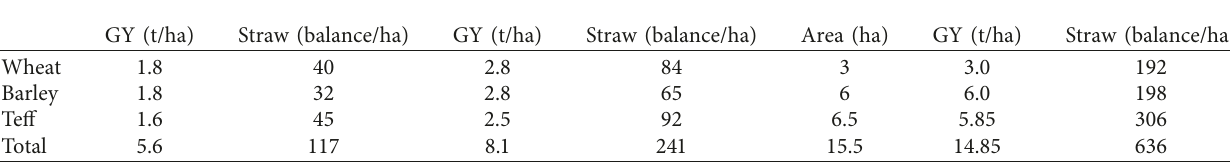
Table 9: Impact of SWC measures on crop yield [40].